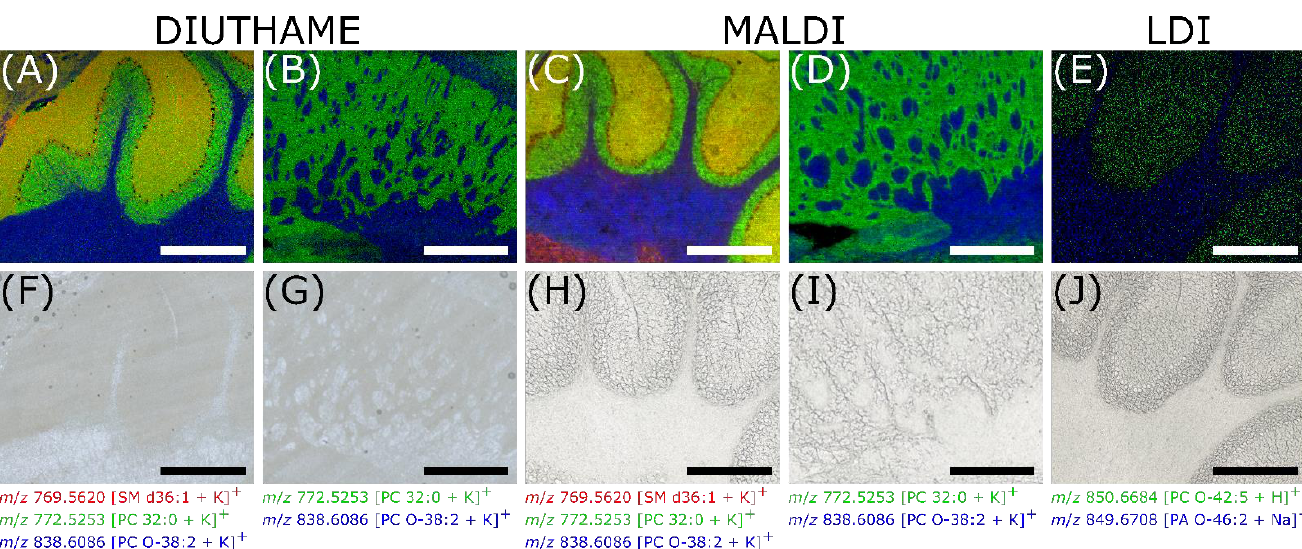
Figure 4. Comparison of DIUTHAME, MALDI and LDI MSI from adjacent mouse brain tissue sections, acquired with a pixel size of 5 µm, an image size of 300 × 250 pixels, a laser focal diameter of 5 µm, in a mass range of m/z 600–1000. ( A ), ( F ), DIUTHAME MS image of mouse brain cerebellum with corresponding microscopic image. ( B , G ), DIUTHAME MS image of mouse brain striatum ventral region with corresponding microscopic image. ( C , H ), MALDI MS image of mouse brain cerebellum with corresponding microscopic image. ( D , I ), MALDI MS image of mouse brain striatum ventral region with corresponding microscopic image. ( E , J ), LDI MS image of mouse brain cerebellum with corresponding microscopic image. Thickness of tissue sections ( A , B ), 50 µm, ( C – E ), 20 µm. Scale bars: 500 µm.